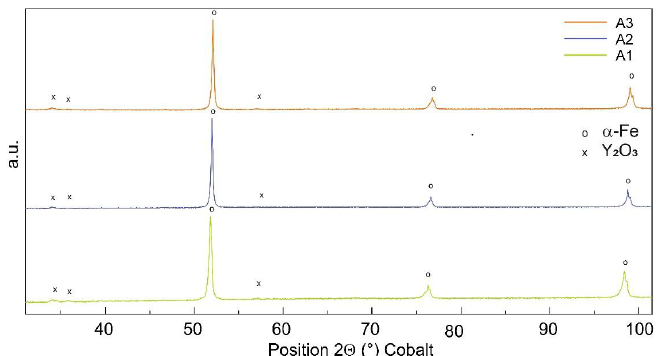
Figure 2. X-ray diffraction (XRD) spectra and phase analysis of studied grades of the new-generation ODS alloy.